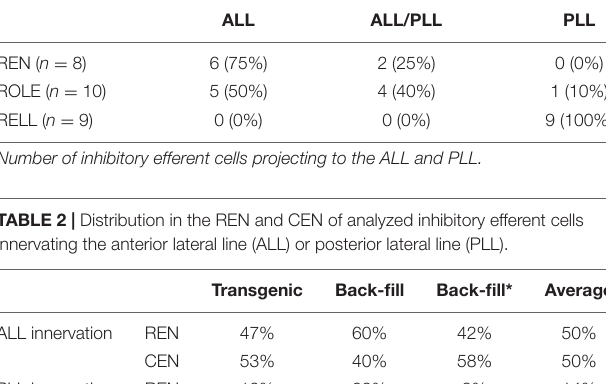
TABLE 1 | Number of REN, ROLE, and RELL cells that project to the anterior lateral line (ALL), posterior lateral line (PLL), or both. ALL ALL/PLL PLL